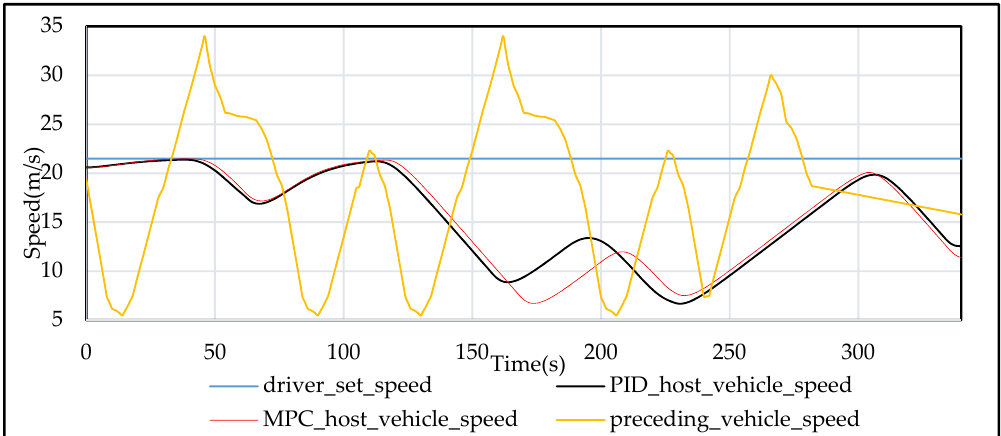
Figure 7. Speed response in scenario 1.